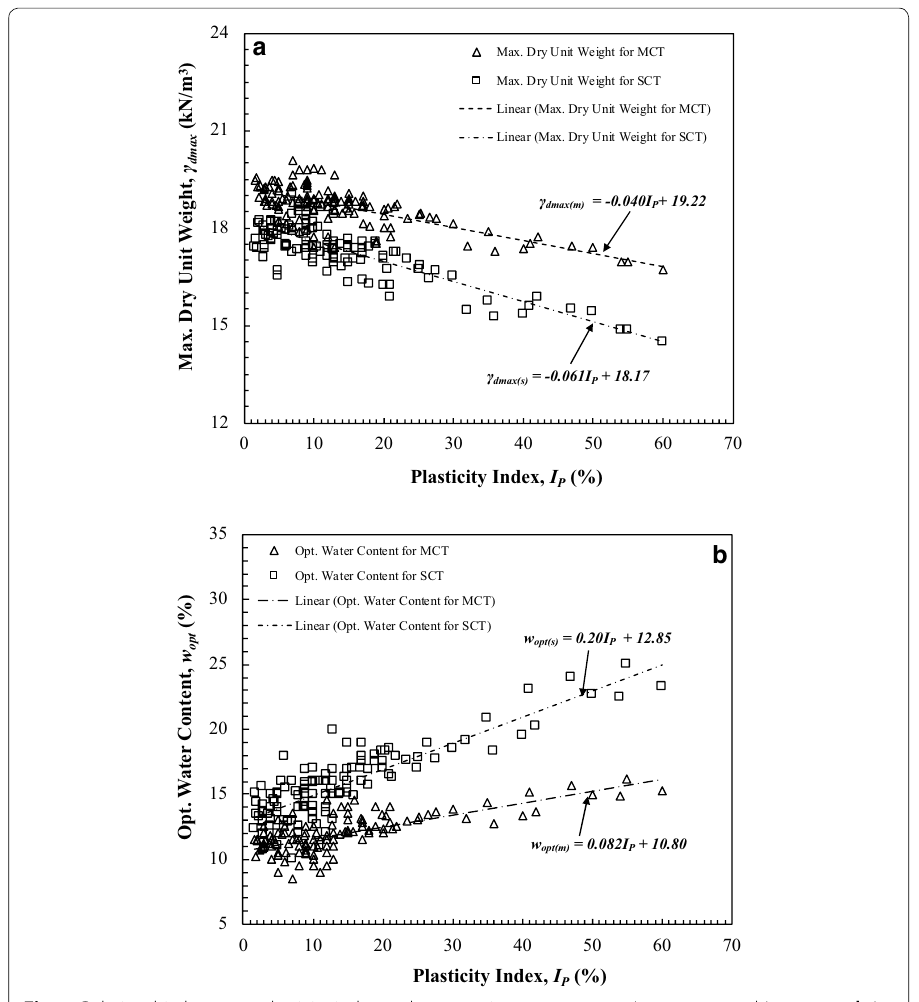
Fig. 7 Relationship between plasticity index and compaction parameters. a I P vs γ dmax(m) and I P vs γ dmax(s) , b I P vs w opt(m) and I P vs w